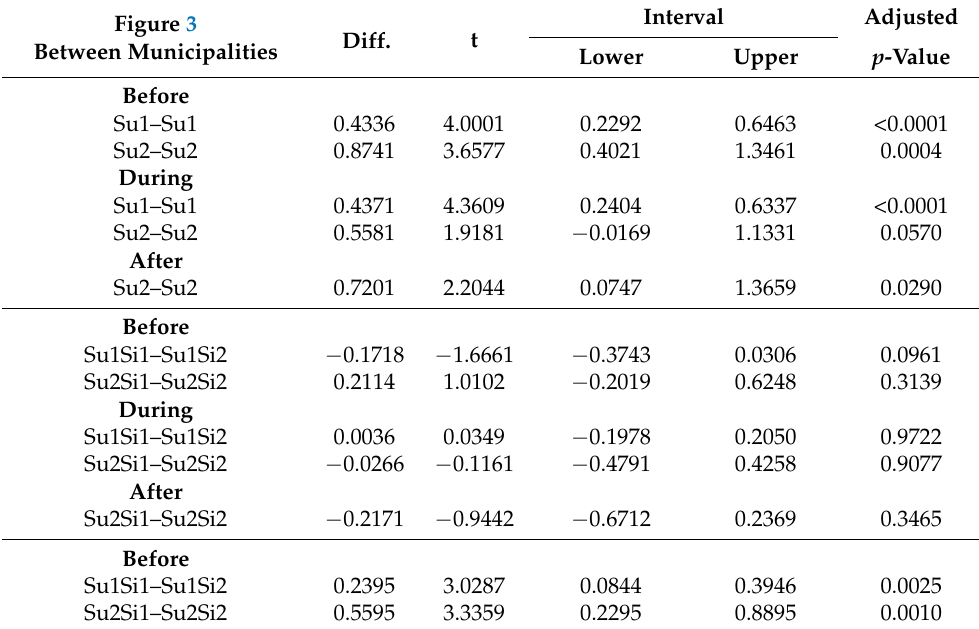
Table A2. Hypothesis tests of means corresponding to Figure 3. Women upper panel, men middle panel and gender differences lower panel. Figure 3 Between Municipalities